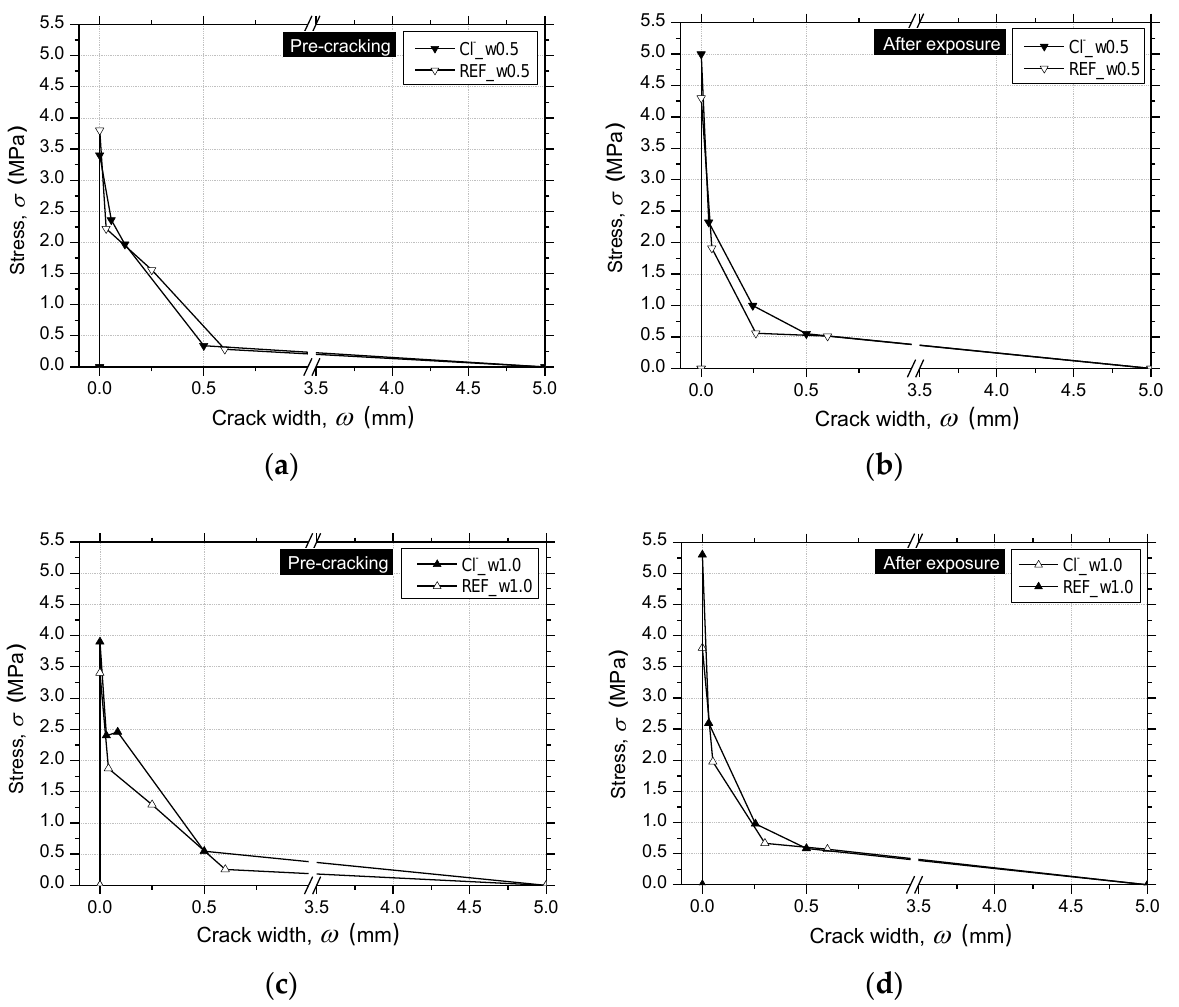
Figure 17. Stress–crack width ( σ − ω ) relationships obtained by inverse analysis from RPT-3ps of RSFRC panels with the